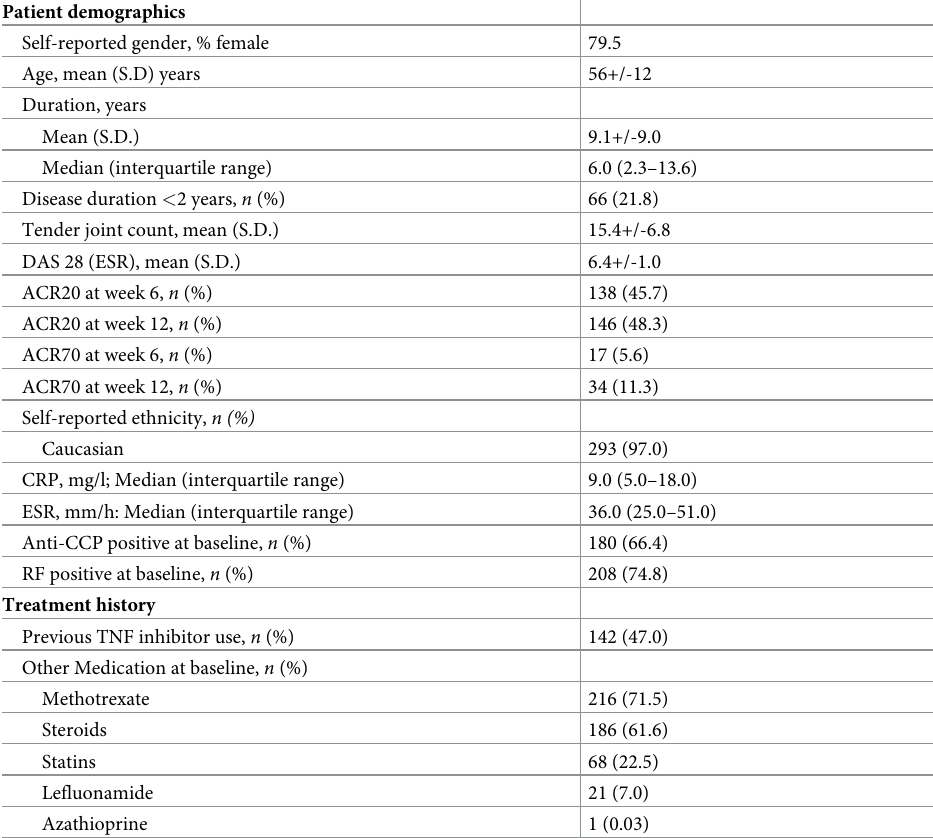
Table 1. Characteristics of study sample for